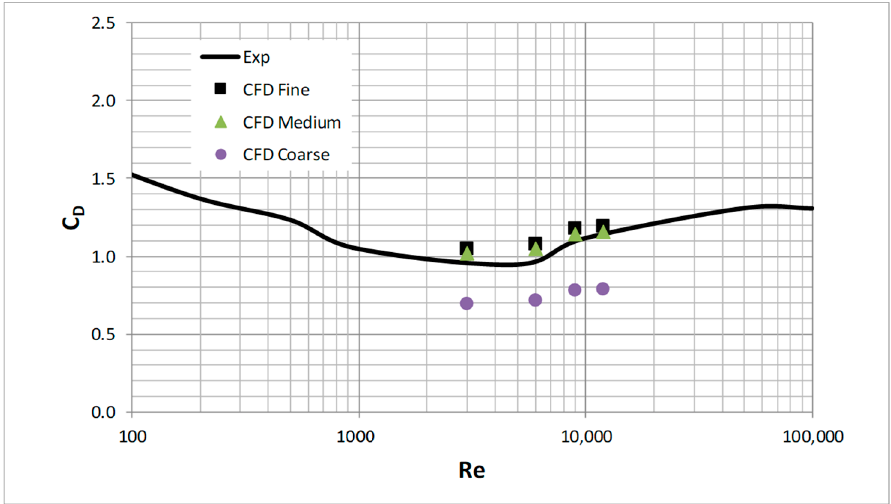
Figure 4. Drag coefficients comparison between the experiments and the current Computational Fluid Dynamics (CFD) simulations.